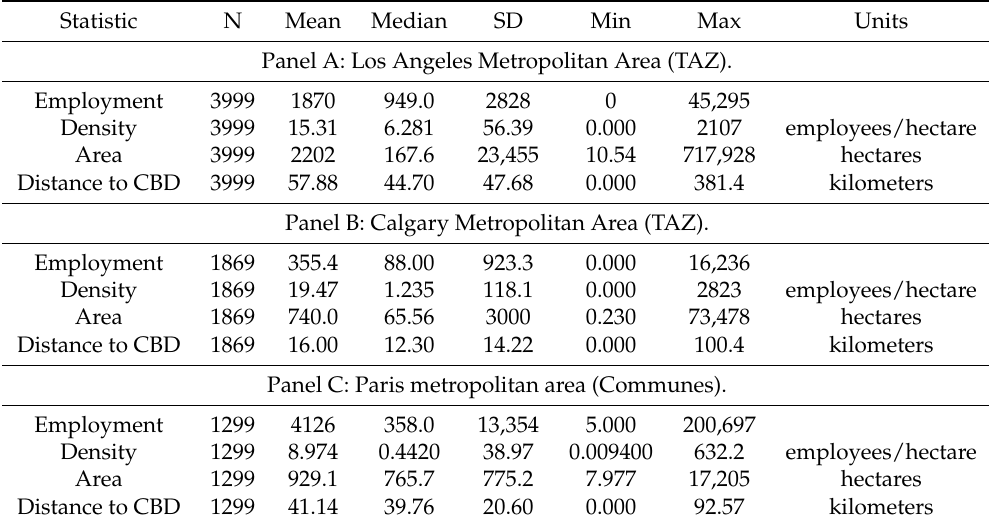
Table A1. Data sources and descriptive